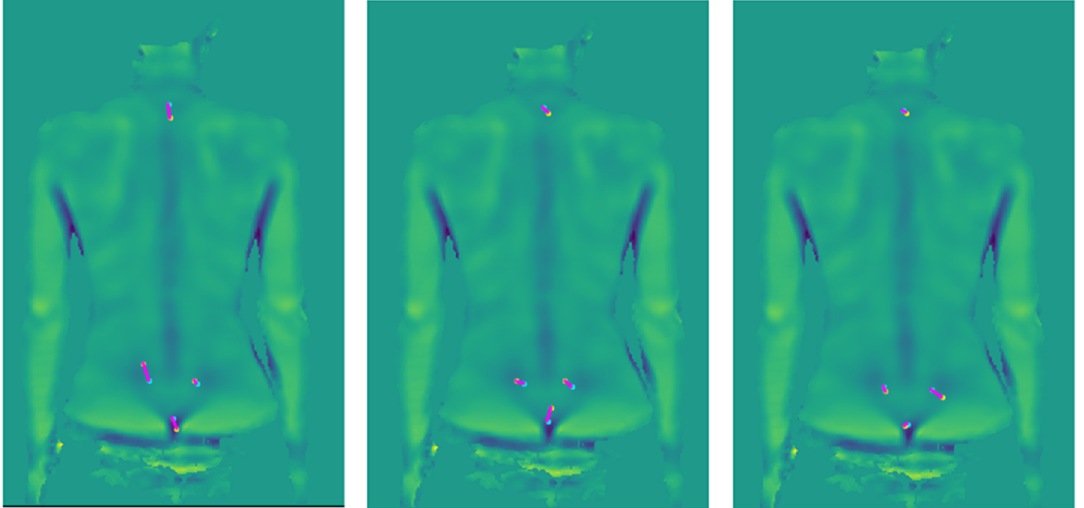
Figure 5. Example of artificial marker displacements. The blue point is the original marker position, and the yellow point is the marker after the displacement, and in magenta is the displacement